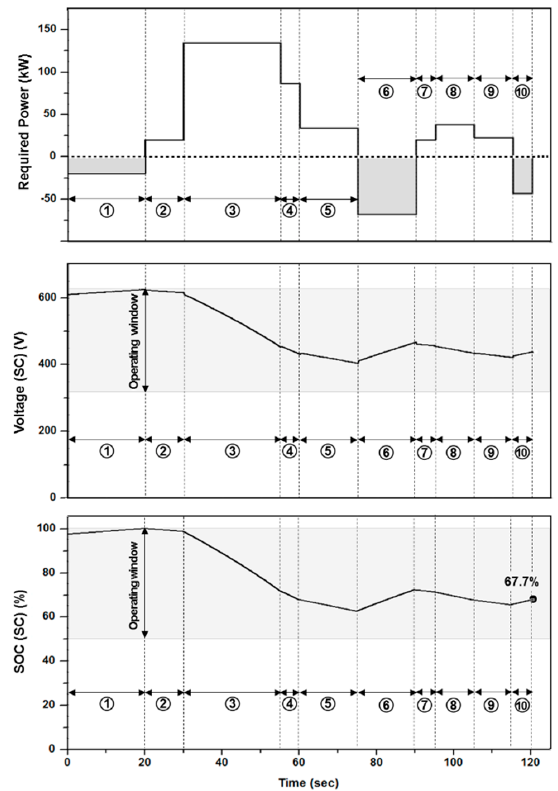
Figure 8. LIB pack voltage and state of charge (SOC) changes (port in/out mode).